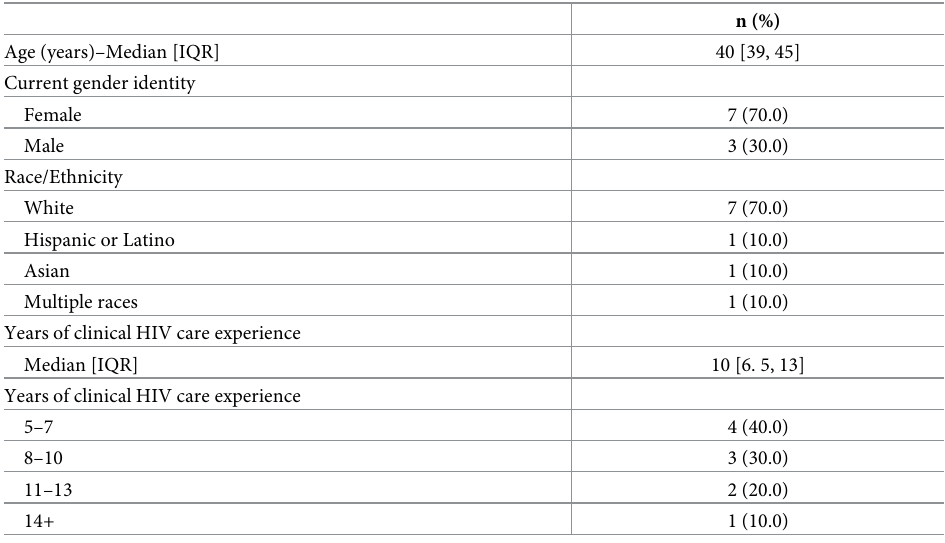
Table 1. Provider